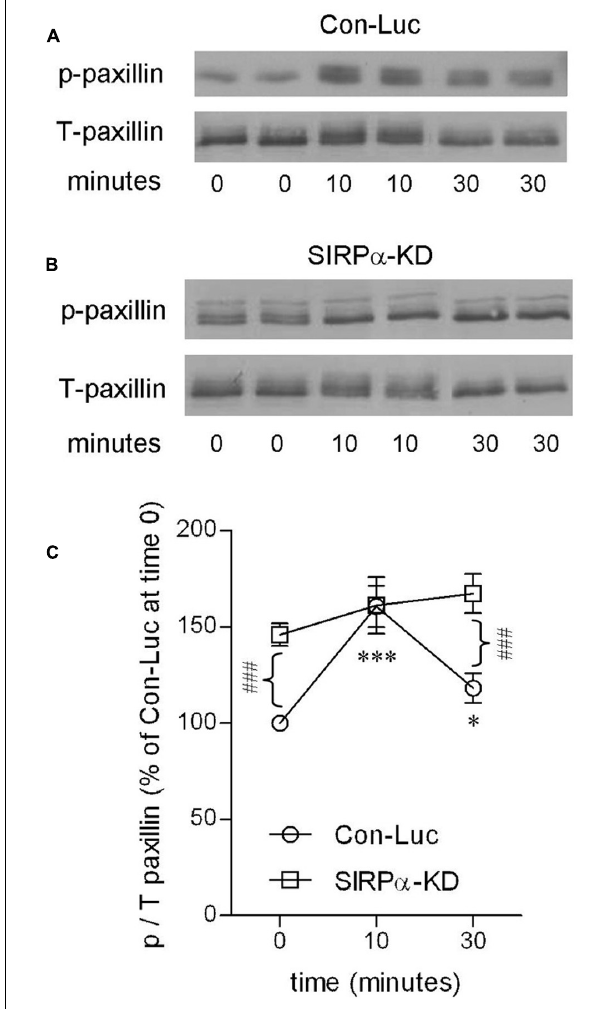
FIGURE 4 | Paxillin activation is transient in phagocytosing control microglia but continuous in phagocytosing SIRP α -KD microglia. Immunoblot analysis of p- andT-paxillin in (A) control (Con-Luc), and (B) SIRP α -KD microglia before the onset of phagocytosis (time 0), and after 10 and 30 min of phagocytosis.The antibodies used for immunoblot analysis identify paxillin and paxillin that is phosphorylated atY 118 . (C) Quantitation of the ratio p/T based on immunoblot analysis.The ratio p/T in non-phagocytosing Con-Luc microglia (i.e., at time 0) was defined 100%. Then p/T in all other non-phagocytosing and phagocytosing microglia was calculated as percentage of p/T in non-phagocytosing Con-Luc microglia. Average values ± SEM of four to eight experiments, each performed in duplicates, are given. Significance of differences between initial values at 0 min and those at 10 and 30 min by one way ANOVA and the Dunnet post test are * p < 0.05 and *** p < 0.001 for Con-Luc microglia. Significance of difference between Con-Luc and SIRP α -KD microglia by two way ANOVA and the Bonferroni post test is ### p < 0.001. Significance of difference between 10 and 30 min in Con-Luc microglia by one way ANOVA and the Tukey’s post test is p < 0.01 (not marked).